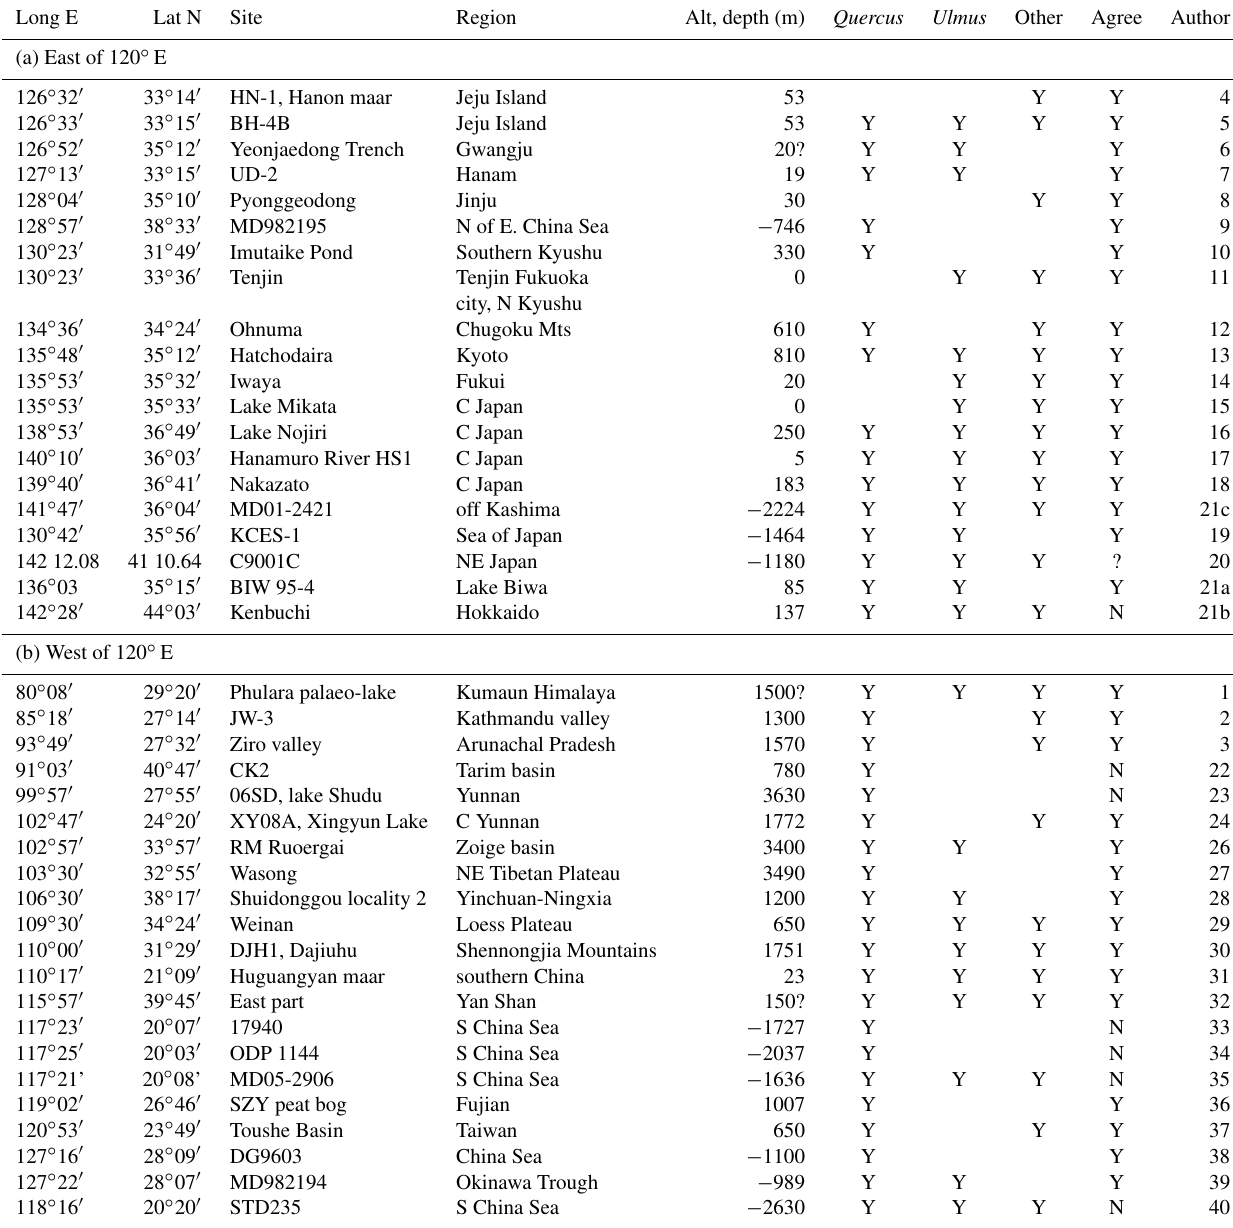
Table 2. Selected sites with observed pollen during the LGM. Quercus includes deciduous Quercus and Lepidobalanus ; Ulmus includes Ulmus–Zelkova ; and “others” include Carya, Tilia and Carpinus . “Agree” means that the observations agree with our estimates of possible tree growth as shown in Fig. 6 or